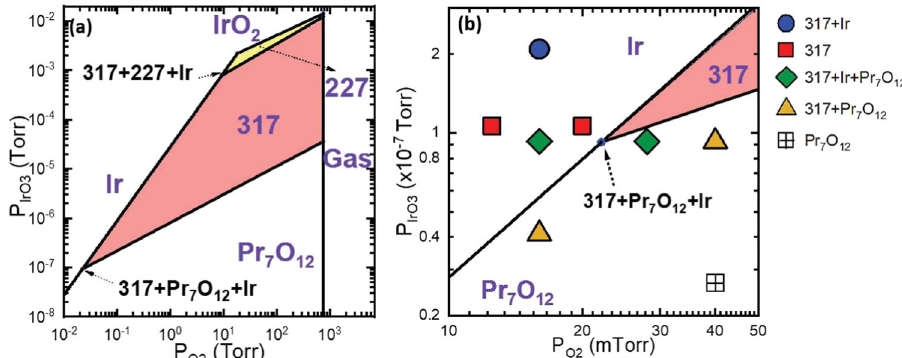
Fig. 4 Calculated potential phase diagram of the Pr-IrO 3 -O 2 system. Calculated potential phase diagram of the Pr-IrO 3 -O 2 system at 1163 K (890 °C) and total pressure of 1 atm (760 Torr) with the partial pressures of O 2 ( P O2 ) and IrO 3 ( P IrO3 ) plotted ( a ), the zoomed-in diagram and the experimental comparison from the co-sputtering results ( b ). In the calculated phase diagram, the points represent three-phase equilibrium, the lines two-phase equilibrium, and the areas one-phase equilibrium. Here, 227 represents Pr 2 Ir 2 O 7 and 317 represents Pr 3 IrO 7 . The cross- point of “ 317 + Pr 7 O 12 + Ir ” is located at [2 × 10 − 2 , 9 × 10 − 8 ] Torr with respect to P O2 and P IrO3 , respectively, whereas the minimum partial pressures are [9, 8 × 10 − 4 ] Torr of the equilibria of “ 317 + 227 + Ir ” in order to form Pr 2 Ir 2 O 7 . It is worth noting that the gas single-phase boundary here located at 760 Torr re fl ects the 1 atm pressure condition of our